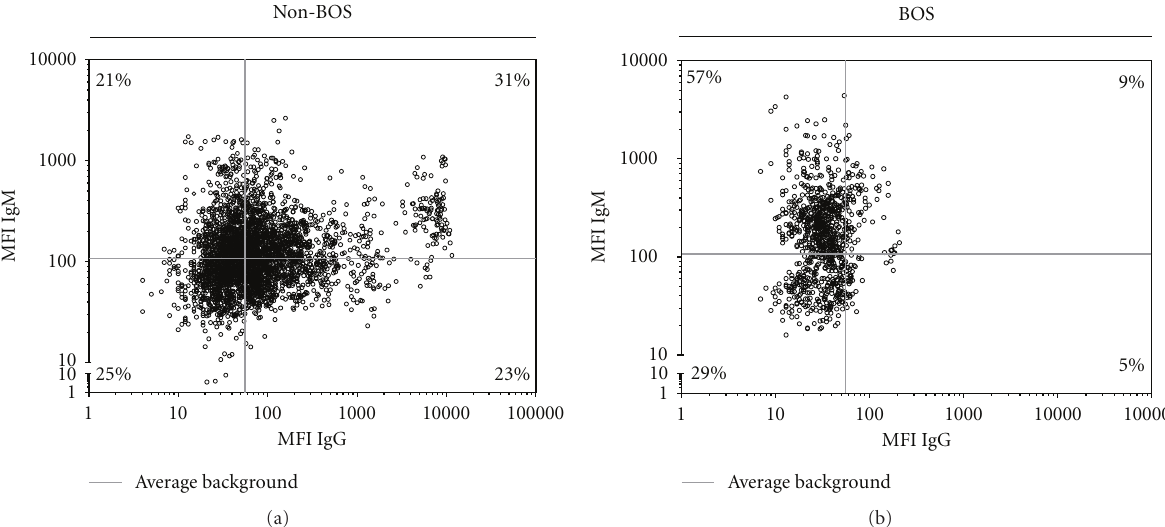
Figure 4: Di ff erences in HLA class I antibody isotype profiles in BOS and non-BOS patients.